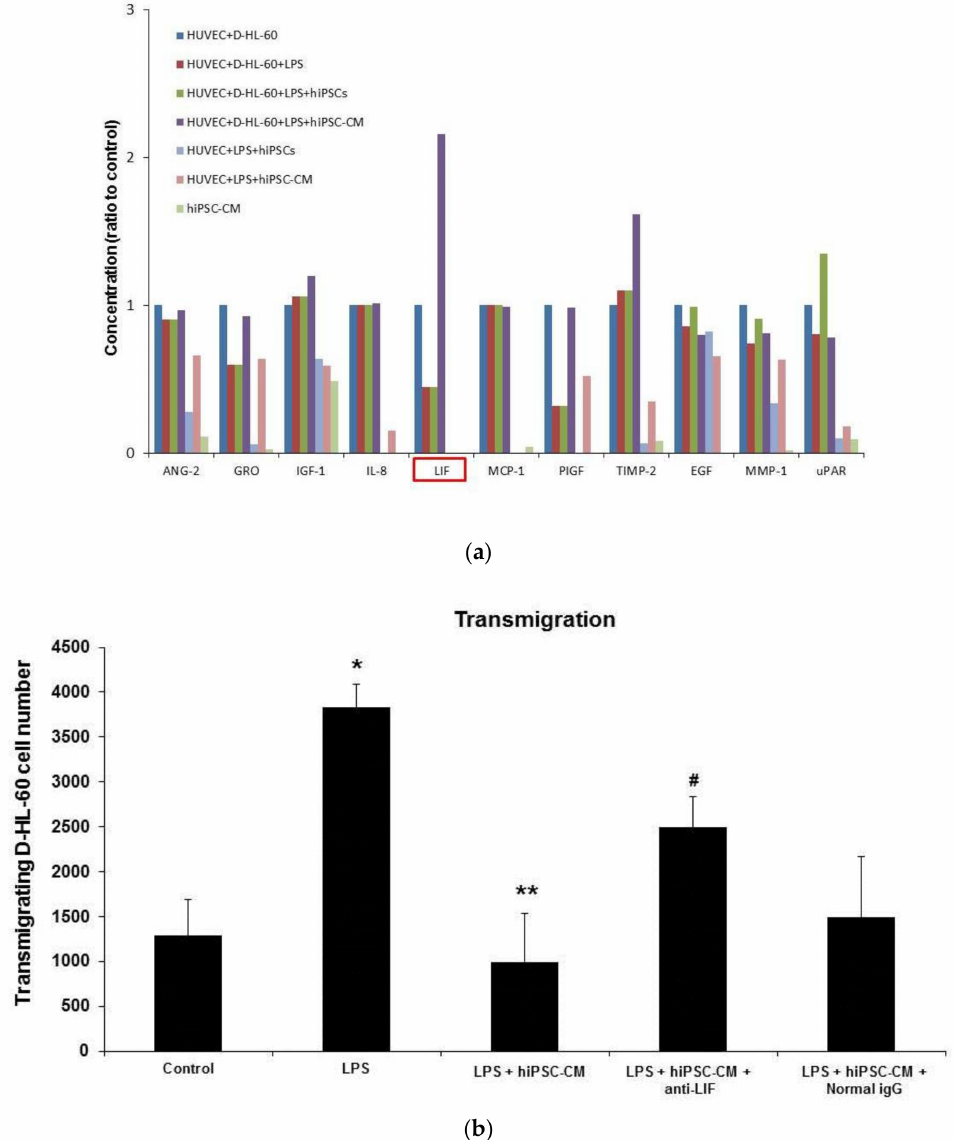
Figure 5. In vitro, iPSC-CM reduced D-HL-60 cell/HUVEC transmigration by inducing endogenous LIF from D-HL-60 cells. ( a ) The human angiogenesis factors protein array confirmed that there was no detectable LIF in hiPSC-CM. Endogenous LIF from D-HL-60 cells was induced after administering hiPSC-CM. ( b ) The D-HL-60 cell/HUVEC transmigration assay showed that administering LPS increased the D-HL-60 cell TEM, which was reduced by hiPSC-CM. Stimulation of LPS on the D-HL-60 cell TEM was significantly reduced by hiPSC-CM. Administration of the anti-LIF antibody inhibited the effect of hiPSC-CM on D-HL-60 cell TEM. Data are presented as the mean ± SD. * p < 0.05, compared to control mice; ** p < 0.05, compared to LPS-induced ALI mice; # p < 0.05, compared to LPS-induced ALI mice that received miPSC-CM; n = 6 per